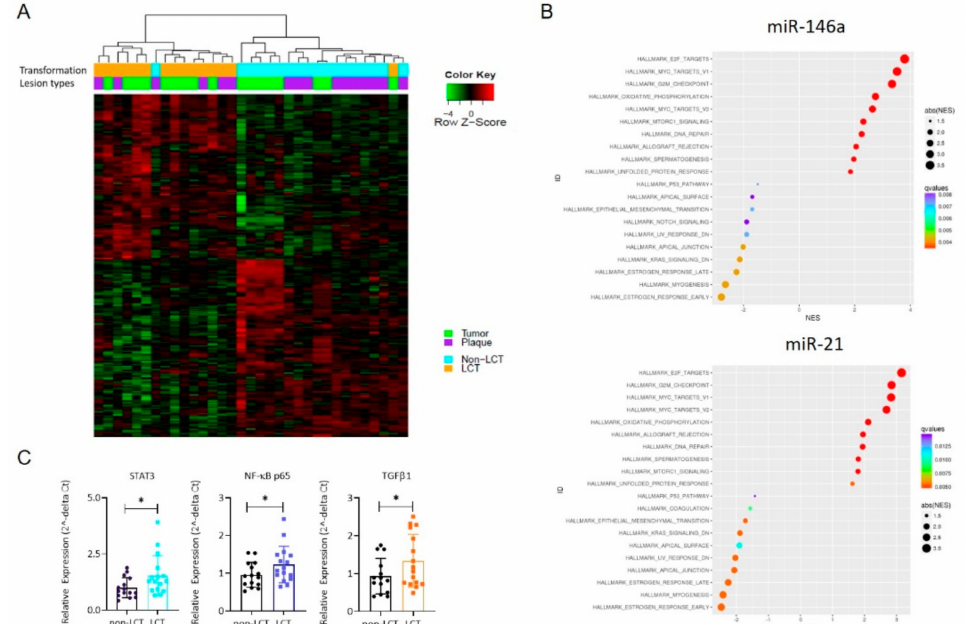
Figure 3. Transcriptional profiles of LCT-MF and non-LCT MF. ( A ) Unsupervised clustering of mRNA seq data of plaques and tumor lesions of LCT-MF segregated from non-LCT MF. ( B ) Hallmark pathway analysis of genes that correlate with miRNA-21 and miR-146a. ( C ) qRT-PCR-based analysis of mRNA expression in MF-LCT and non-LCT lesional skin samples. The data are presented as means ± SD. Differences between means were analyzed using Student’s t test (* p < 0.05).